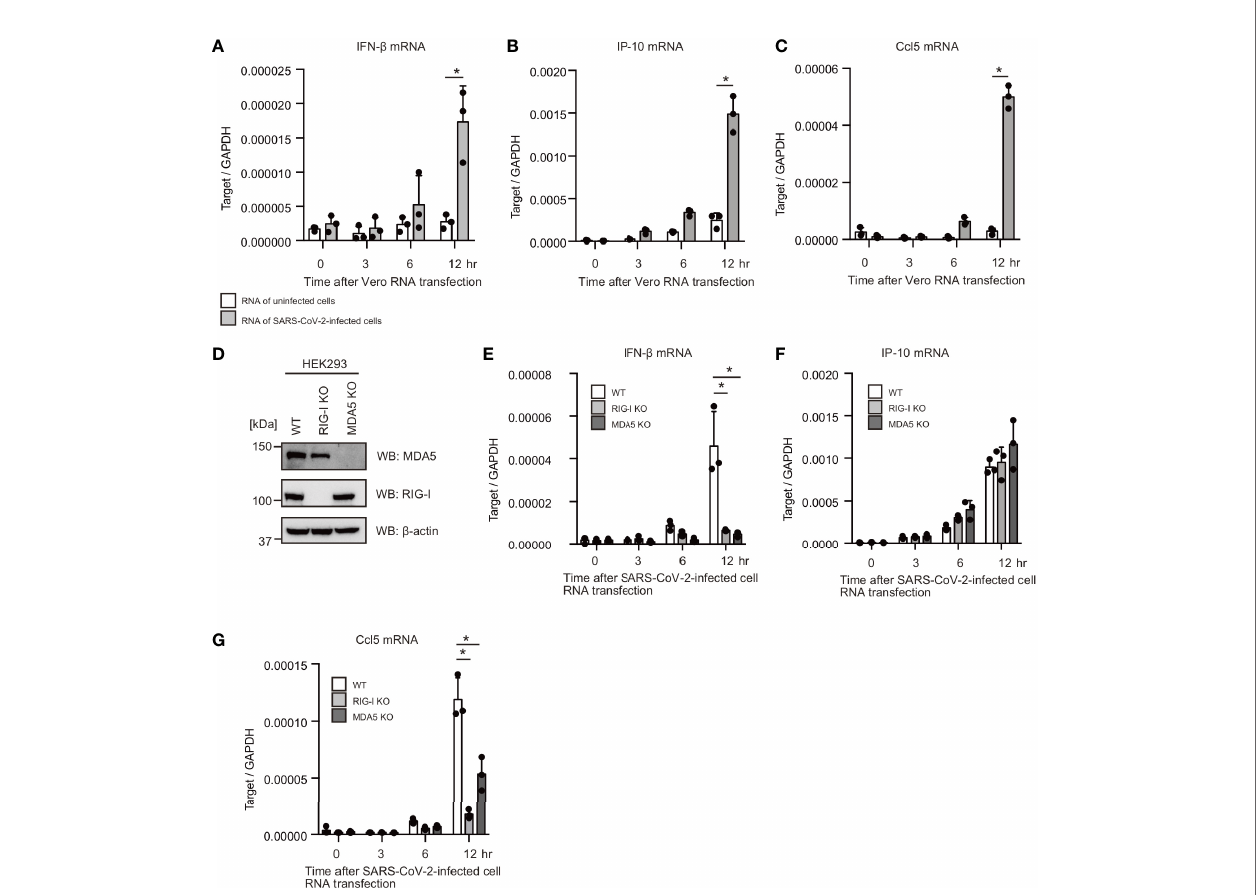
FIGURE 1 | Total RNAs of SARS-CoV-2-infected cells induce type I IFN expression. (A – C) Total RNAs were extracted from VeroE6/TMPRSS2 cells infected with mock or SARS-CoV-2 for 24 h. 1 m g of extracted RNA was transfected into HEK293 cells, and IFN- b (A) , IP-10 (B) , and Ccl5 (C) mRNA expression at indicated time points were determined by RT-qPCR (n = 3). The data shown is representative of two independent experiments. (D) Whole cell extracts of WT, RIG-I KO, and MDA5 KO HEK293 cells were prepared and subjected to SDS-PAGE. The proteins were detected by western blotting using anti-RIG-I, MDA5, and b -actin antibodies. (E – G) 1 m g of the total RNA from VeroE6/TMPR22S infected with SARS-CoV-2 was transfected into WT, RIG-I KO, and MDA5 KO cells. IFN- b (D) , IP-10 (E) , and Ccl5 (F) mRNA expression at indicated time points were determined by RT-qPCR (n = 3, *p < 0.05, t-test). The data shown is representative of two independent